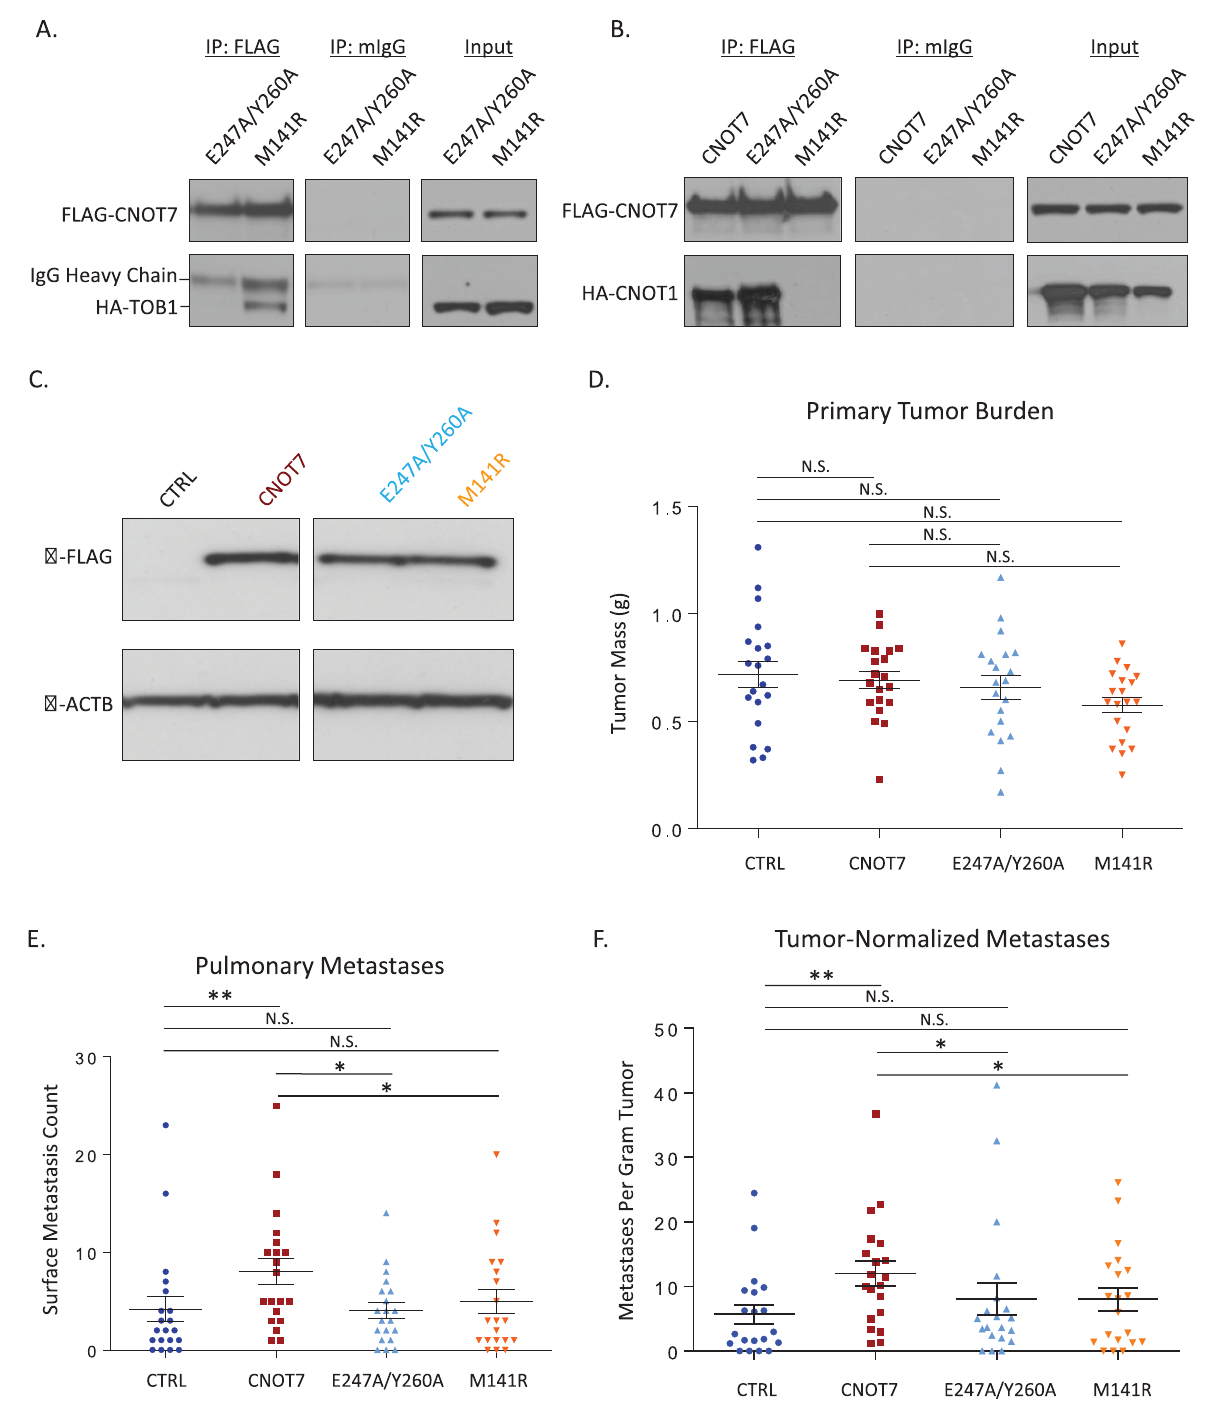
Fig 7. Co-immunoprecipitation of the Cnot7 mutants confirming the specific disruption of interaction with TOB1 by the E247A/Y260A mutant (A). Co-immunoprecipitation of the Cnot7 mutants confirming the specific disruption of interaction with CNOT1 by the M141R mutant (B). Western blot confirming the equal expression of Cnot7 constructs in cells used for spontaneous metastasis assays (C). Dot plot of the primary tumor mass for Cnot7 wildtype and mutant cells orthotopically implanted into mice (D). Surface metastasis plot results of orthotopically implanted 4T1 cells expressing mutant Cnot7 constructs (E). Dot plot of the surface pulmonary metastasis count for orthotopically constructs normalized for primary tumor burden